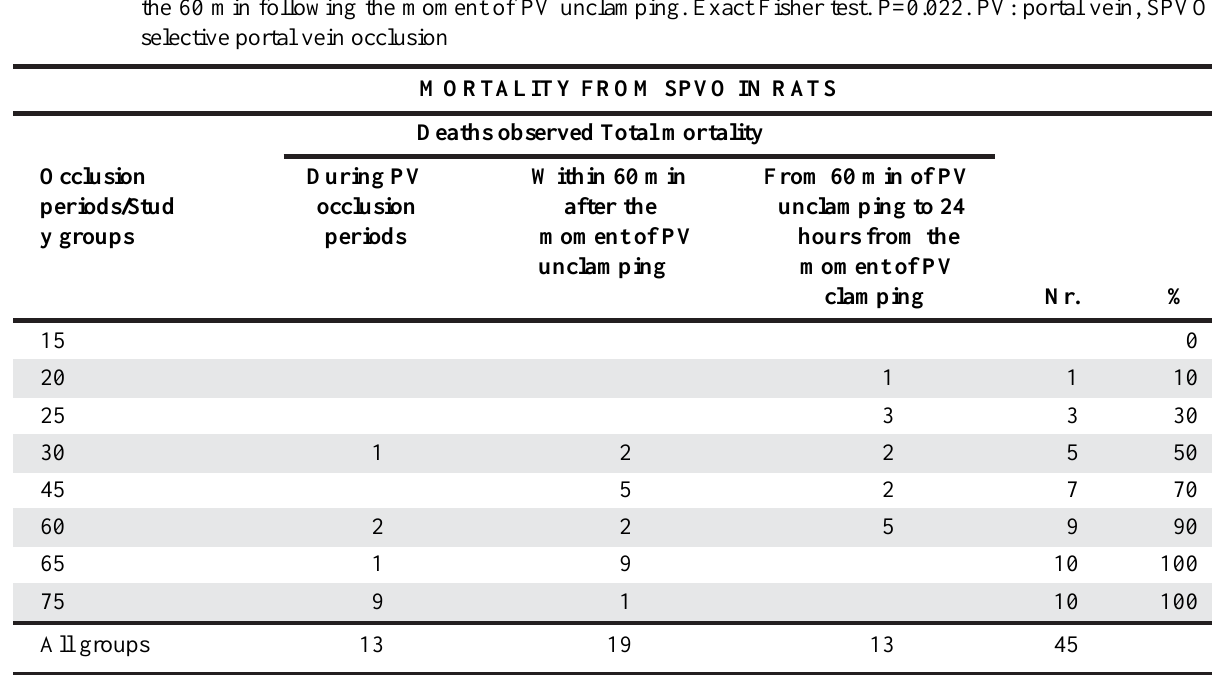
TABLE 2 - Deaths resulting from periods of 20 and 25 min of SPVO occurred after 60 min following the unclamping moment, whereas deaths resulting from SPVO periods of 30 min or longer occurred predominantly during the 60 min following the moment of PV unclamping. Exact Fisher test. P=0.022. PV: portal vein,